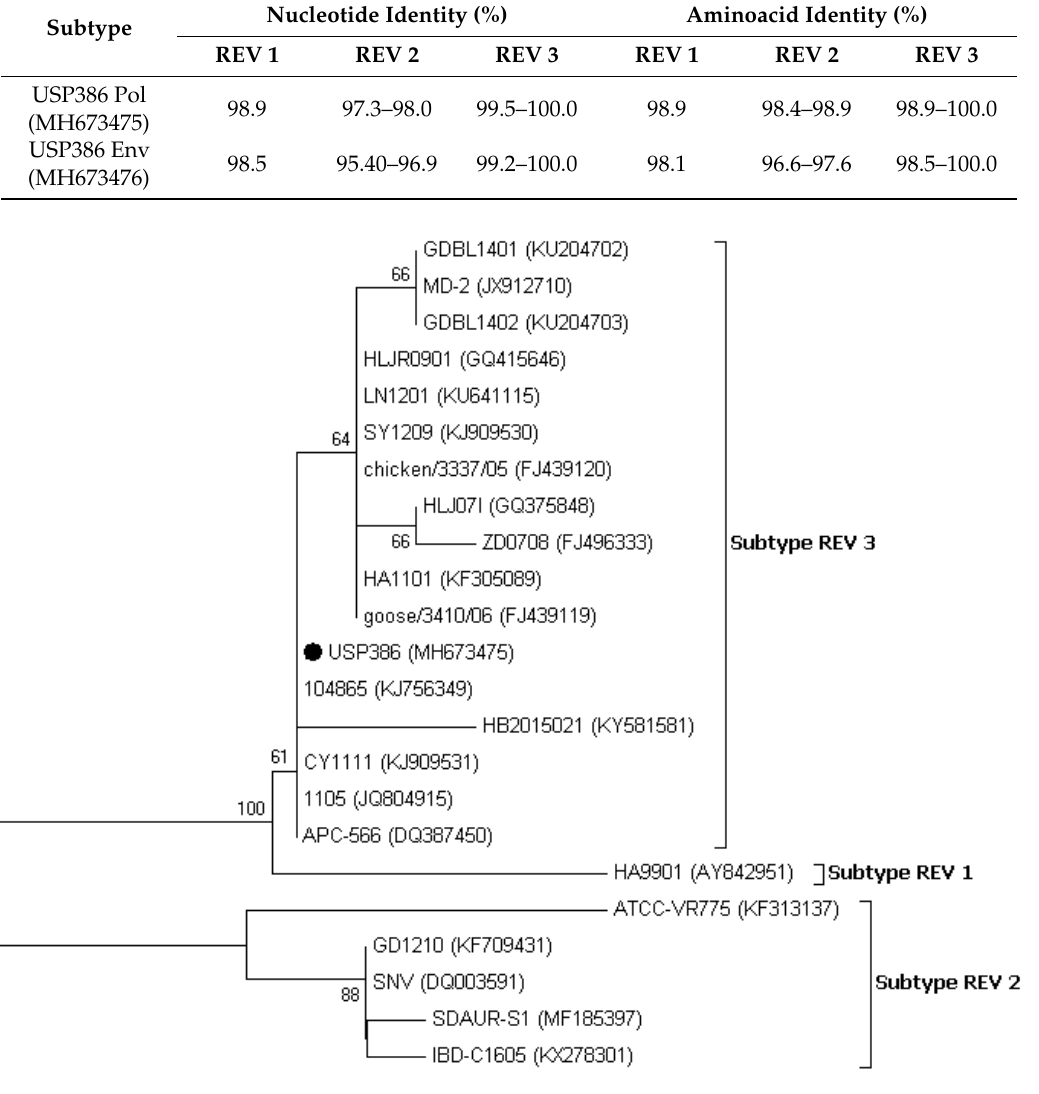
Table 5. The nucleotide and deduced amino acid identities of the USP386 and REV subtypes. Figure 3. Phylogenetic analysis of the nucleotide sequences of the MDV strains based on the partial gB gene. The strain names and GenBank accession numbers are shown. The black circle represents the field MDV strain used in this study. The black rhombus represents the MDV vaccinal control strains. The phylogenetic tree was constructed in MEGA v7.0 using the Neighbor-Joining method with 1000 bootstrap replicates. The evolutionary distances were computed using the Kimura 2- parameter model (K2 + G + I), and the scale bar represents the number of base substitutions per site.